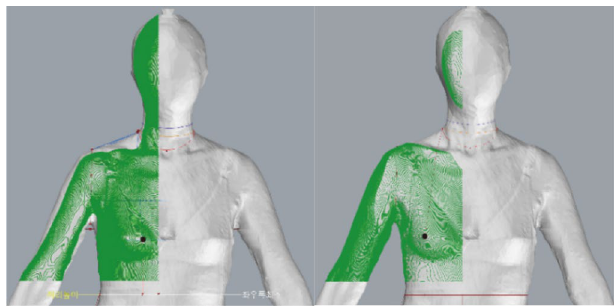
Fig. 11 Comparison of bust points set according to the direction of the contour. (left: 0°, right: 35°)